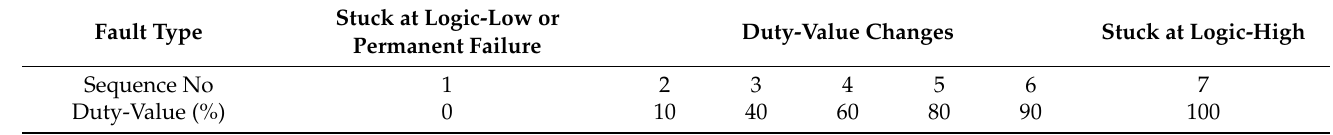
Table 4. Duty-value change used for different experiment